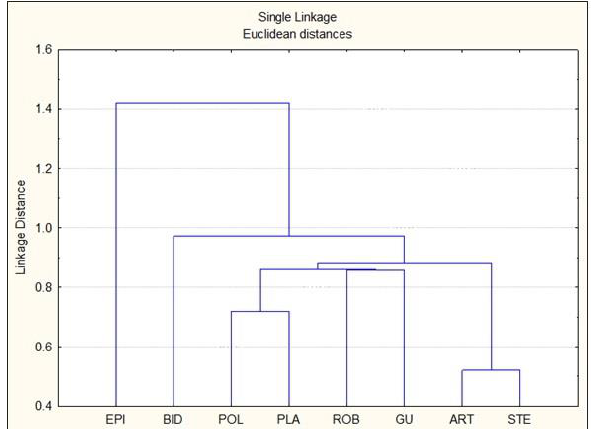
Fig. 2. Similarity of the alien species composition of the ruderal phytocoenoses of